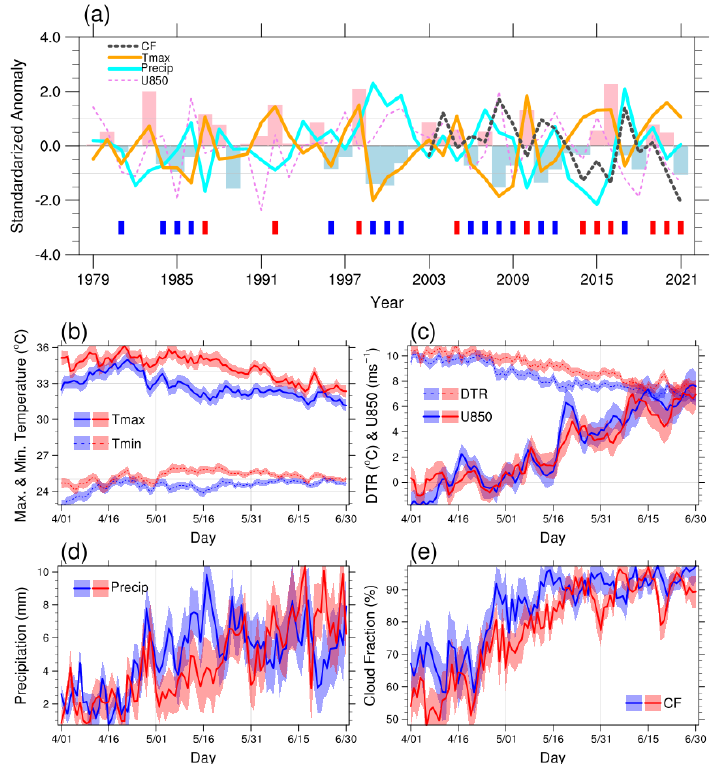
Figure 3. ( a ) Time series of the standardized monthly anomalies of daily maximum temperature (Tmax), precipitation (Precip), zonal wind component at 850 hPa (U850), and cloud fraction (CF). The analysis period is from 1979 to 2021 for all the variables except CF, for which a shorter period from 2003 to 2021 is applicable. The bar chart displays the winter ONI with pink (light blue) denoting a positive (negative) anomaly. The ONI is the SST anomaly in ◦ C. The blue (red) filled rectangles along the time axis denote the cold (warm) years of a standardized Tmax anomalous value below 0.5 (exceed 1) standard deviation. See text for details. The daily time series of cold (blue) and warm (red) years consist of ( b ) daily maximum and minimum temperatures, ( c ) diurnal temperature range (DTR) and U850, ( d ) precipitation, and ( e ) CF. The composites are computed for the 91-day span of calendar days from 1 April to 30 June derived from 8 cold and 8 warm years, respectively, as indicated in panel ( a ). Only the cold and warm years during the period from 2003 to 2021 are used for the composites. The horizontal gray lines in panel ( b ) indicate 24, 25, 33, and 34 ◦ C. The vertical gray lines indicate 1 May and 31 May, respectively. All the time series shown are area averages over the ICP region, as indicated in Figure